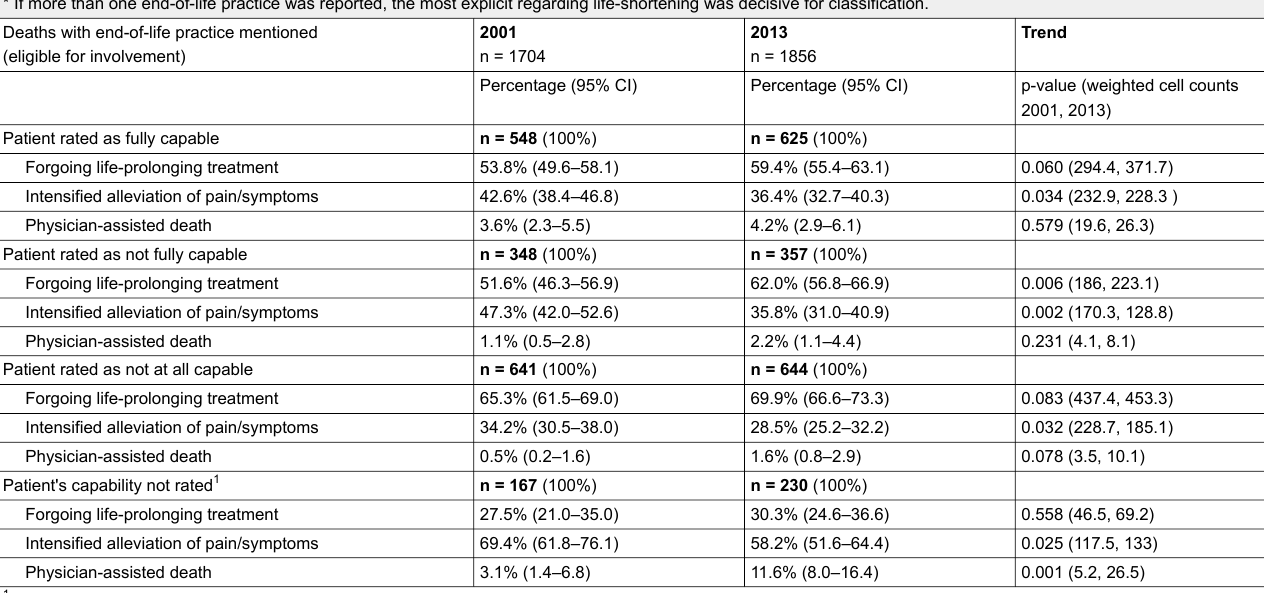
Table S1: Medical end-of-life decisions* by level of patient's decision-making capacity, German-speaking part of Switzerland 2001 vs 2013. (100% = all deaths with reported end-of-life practice; percentages weighted and standardized to 2013